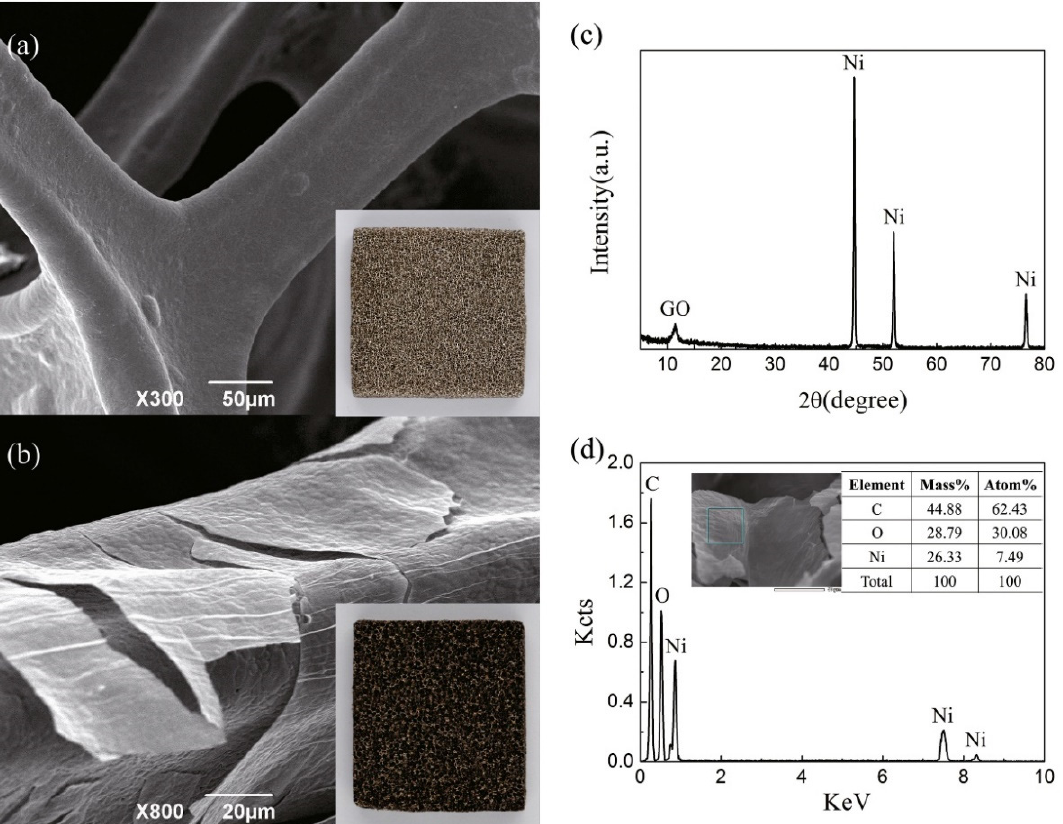
Figure 1. Characteristics of PGO-Ni electrodes. Reprinted with permission ( a ) SEM observations of the microstructure of nickel foam; ( b ) SEM observations of the micro-structure of PGO-Ni electrode; ( c ) XRD patterns of PGO-Ni electrode showing the peak of graphene oxide at 12° and the peaks of nickel at 44°, 52°, 76°. ( d ) EDS patterns of PGO-Ni electrode showing the elements C, O, Ni. from Ref. [84]. Copyright 2017, Elsevier B.V.